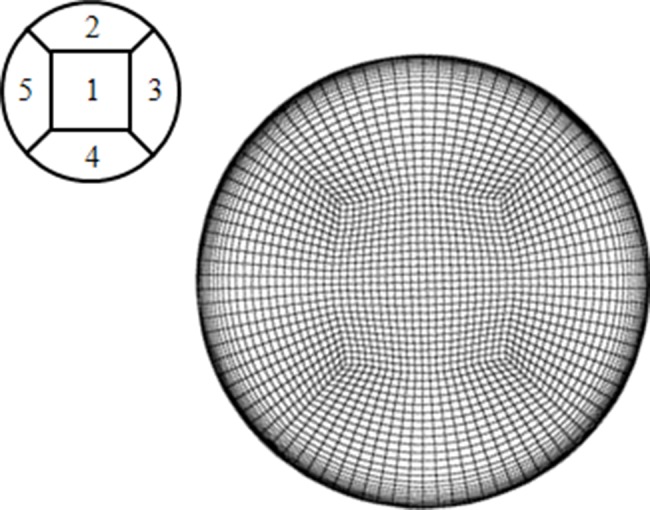
Computational grid and block arrangement.